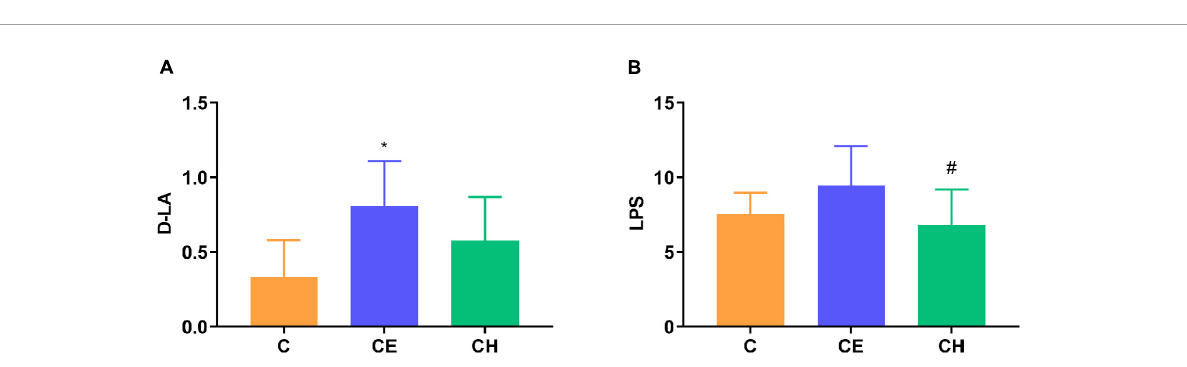
FIGURE5 Serum D-lactic acid (D-LA) and lipopolysaccharide (LPS) levels; (A) Serum D-LA level; (B) Serum LPS level; *Means are significantly different vs. C group (* p < 0.05); # Means are significantly different vs. CE group ( # p < 0.05); Data are represented as the mean ± standard deviation ( n = 8); C, control group; CE, cold exposure group; CH, Chinese herbs complex